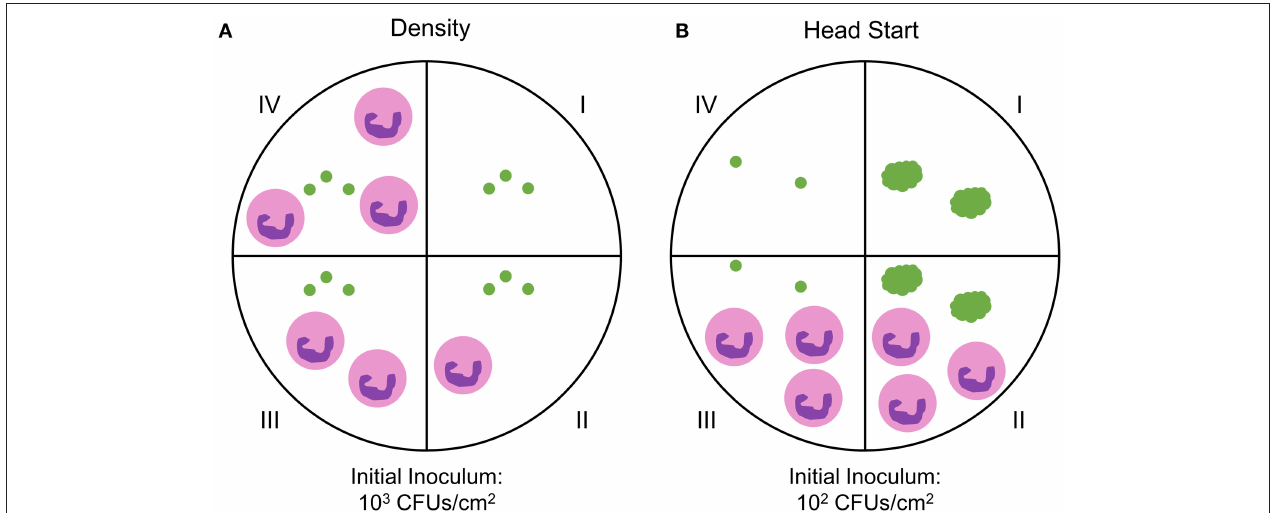
FIGURE 1 | Experimental setup for probing PMN- S. aureus interactions. Two FOVs were imaged in each well unless otherwise noted. (A) S. aureus cells were attached to the dish surface at an initial inoculum of ∼ 10 3 CFUs/cm 2 . A single well-contained S. aureus only (green dots, well I) while all other wells received S. aureus and PMNs (pink circles, wells II - IV). S. aureus —PMN interactions were then imaged for 4h. N = 10 independent experiments producing n = 20 fields of view (FOV) (control wells), n = 8 FOVs (“low” PMN concentration), n = 18 FOVs (“medium” PMN concentration), n = 14 FOVs (“high” PMN concentration). The data are unbalanced for the different neutrophil concentrations. (B) S. aureus cells were attached to the dish surface at an initial inoculum of ∼ 10 2 CFUs/cm 2 . To aggregate cells, S. aureus was incubated for 4h after initial attachment (wells I and II). Single S. aureus cells were attached in control wells (wells III and IV) at the 4h time point for comparison to non-aggregated cells. PMNs were then added to treatment wells (wells II and III) and imaged for 4h. One well per condition (wells I and IV) was not treated with PMNs. N = 6 independent experiments with 12 FOVs per condition.